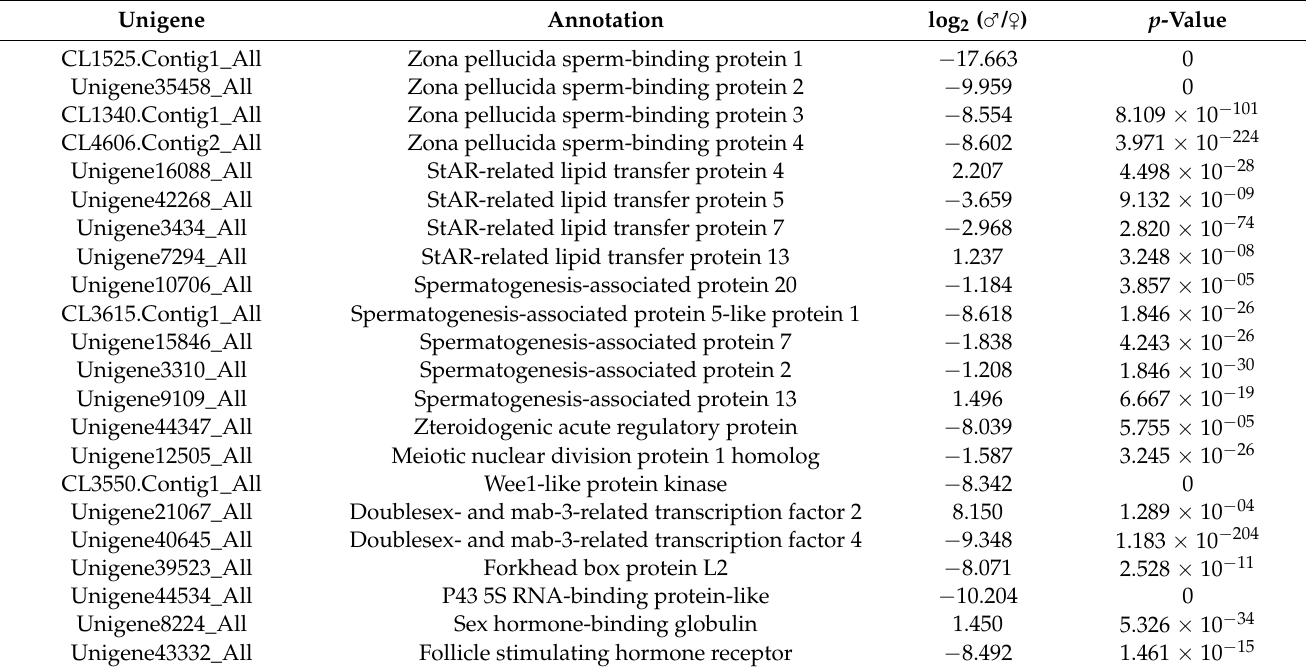
Figure 5. KEGG pathway enrichment analyses of the DEGs.